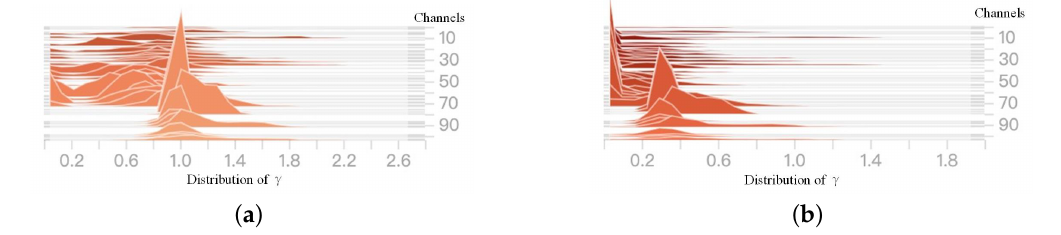
Figure 10. Comparison of gamma distribution before and after training. ( a ) Before sparse training. ( b ) After sparse training.